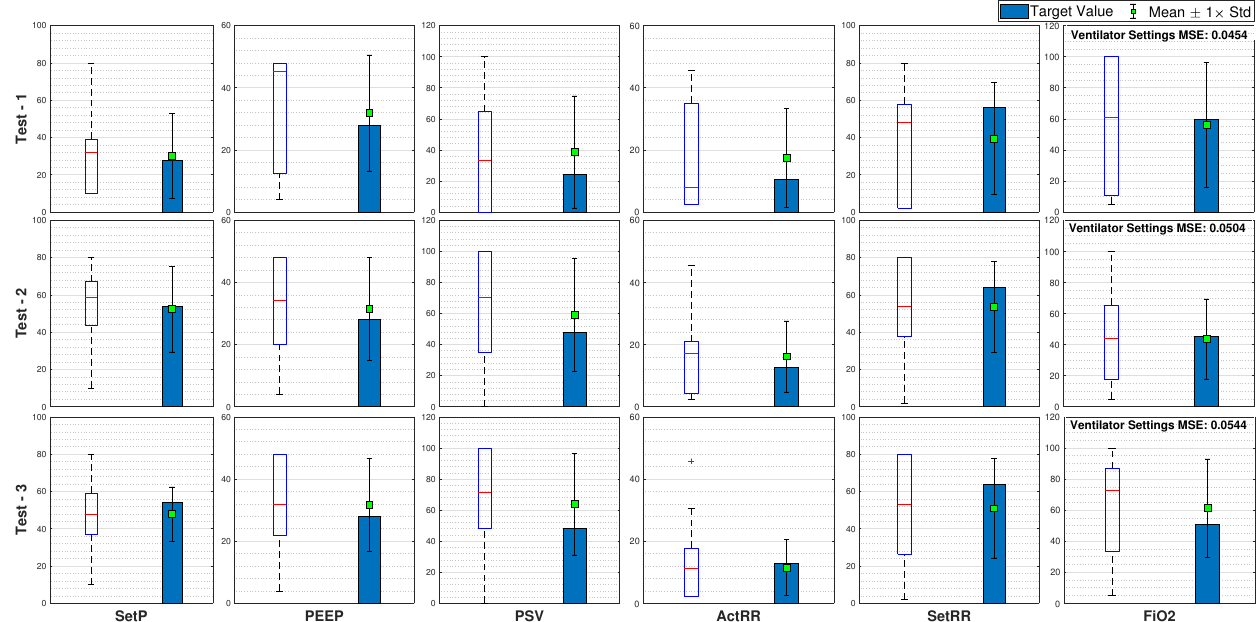
Figure 6. Statistics of results obtained on 10 test cases for 4 different ventilator